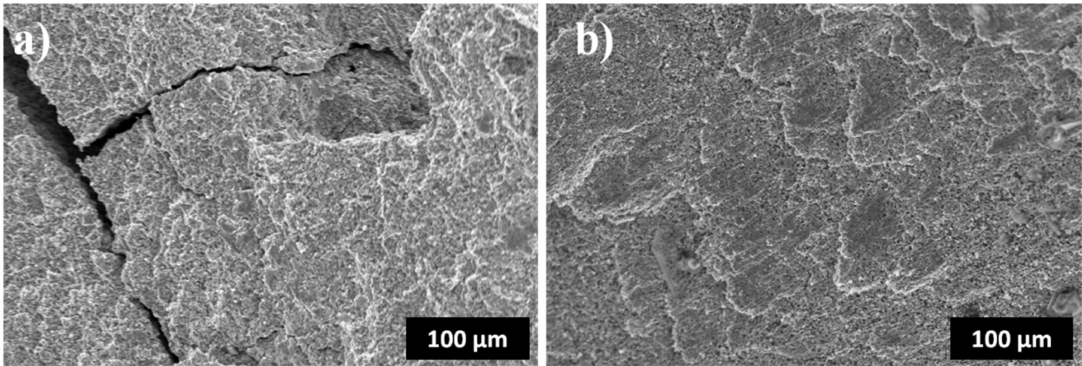
Figure 10. Fractography by SEM of the fracture surfaces of the specimens consolidated by SPS, ( a ) SPS at 750 ◦ C and ( b ) SPS at 1000 ◦